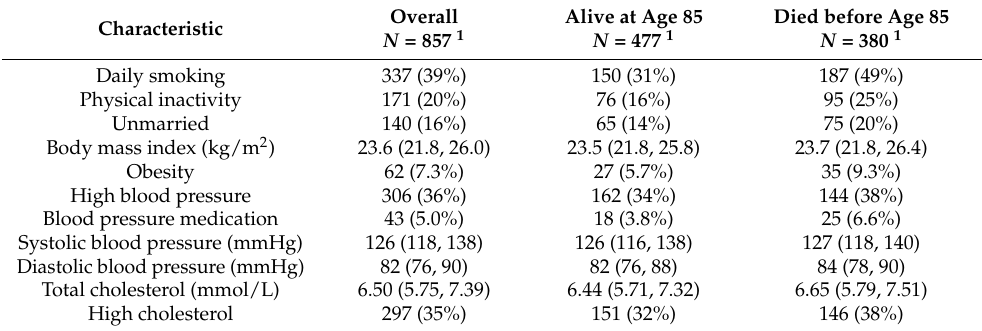
Table 1. Descriptive statistics of risk factors in the study sample at age 45–49 years (Tromsø2), according to survival to age 85. The Tromsø Study